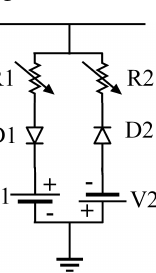
Figure 7. IEEE 13 node test feeder.